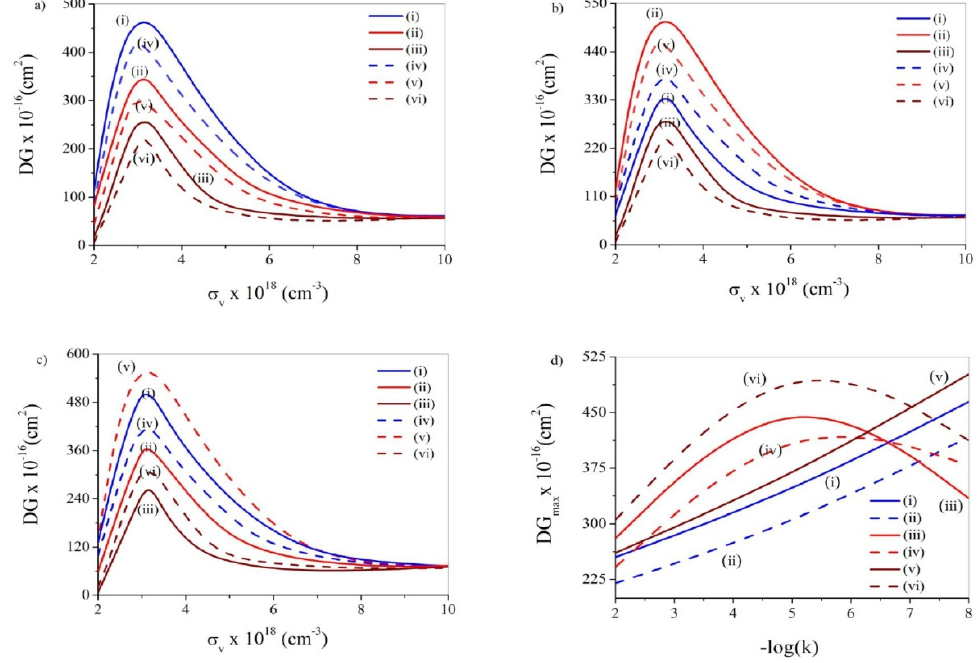
Figure 22. Plots of DG vs. σ v ( a ) without noise, ( b ) with ADWN and ( c ) with MLWN. In these diagrams (i) OPA and k = 10 − 8 , (ii) OPA and k = 10 − 5 , (iii) OPA and k = 10 − 2 , (iv) EPA and k = 10 − 8 , (v) EPA and k = 10 − 5 , (vi) EPA and k = 10 − 2 . ( d ) Depiction of DG peak values vs. − log(k): (i) in absence of noise and under OPA, (ii) in absence of noise and under EPA, (iii) with ADWN and under OPA, (iv) with ADWN and under EPA, (v) with MLWN and under OPA and (vi) with MLWN and under EPA.